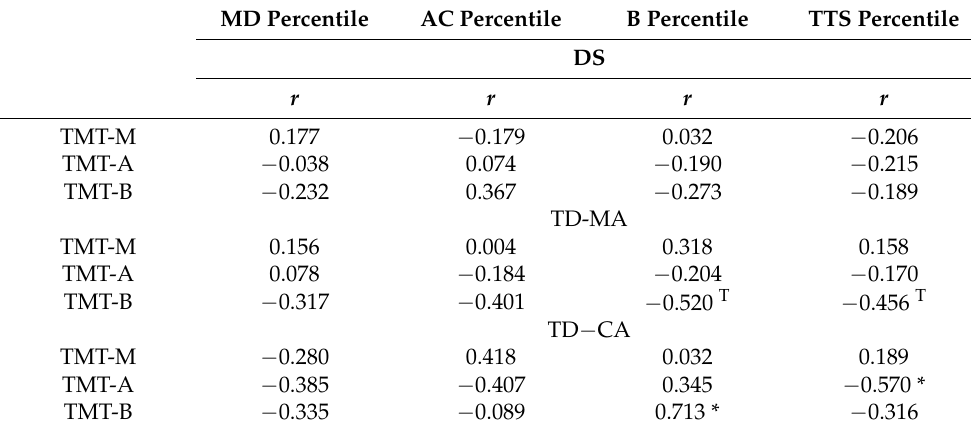
Table 2. Partial correlations ( r ) across cognitive (Trail-Making Test) and motor (Movement Assessment Battery for Children-2) indices for the sample of TD-MA ( n = 12), TD-CA ( n = 12) and children with DS ( n = 12) controlled for sports participation and sex. MD Percentile AC Percentile B Percentile TTS Percentile DS 0.177 − 0.179